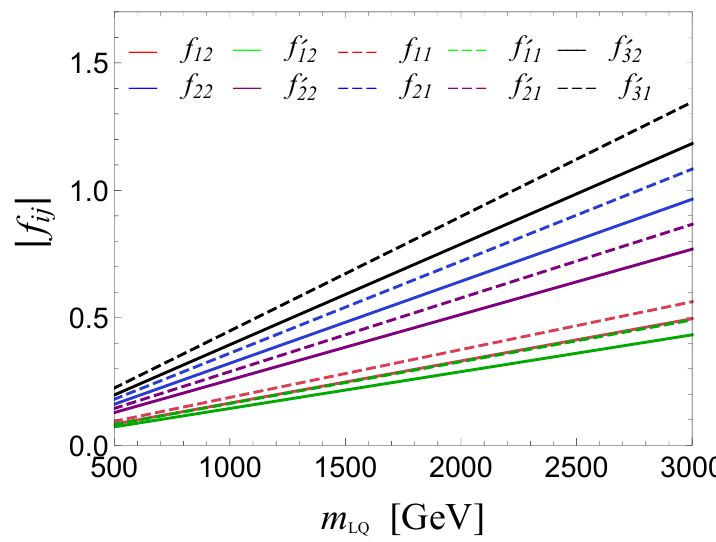
Figure 8 . Summary of the new indirect constraints on the Yukawa couplings of the R 2 LQ as a function of its mass from a recent non-resonant dilepton search at the